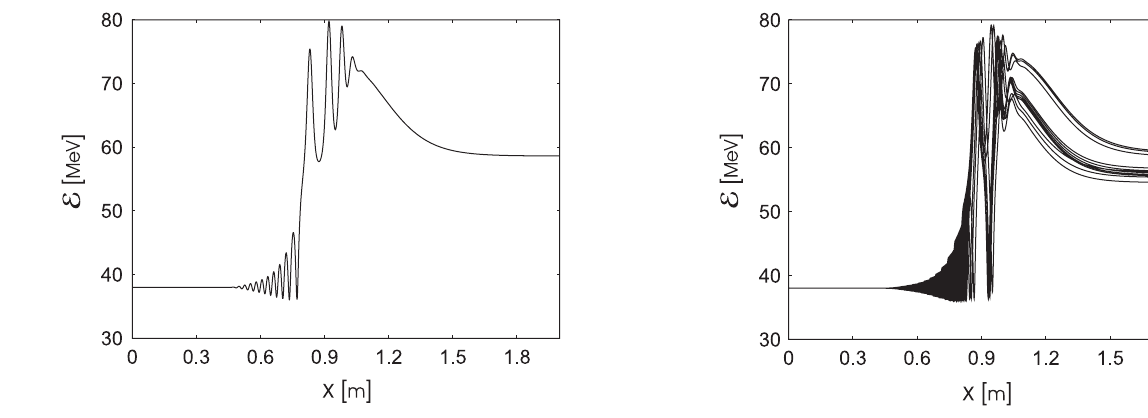
FIG. 1. Reflection of a particle from a plane laser pulse of finite duration. The energy versus the position x is plotted when the laser intensity is above the critical point.